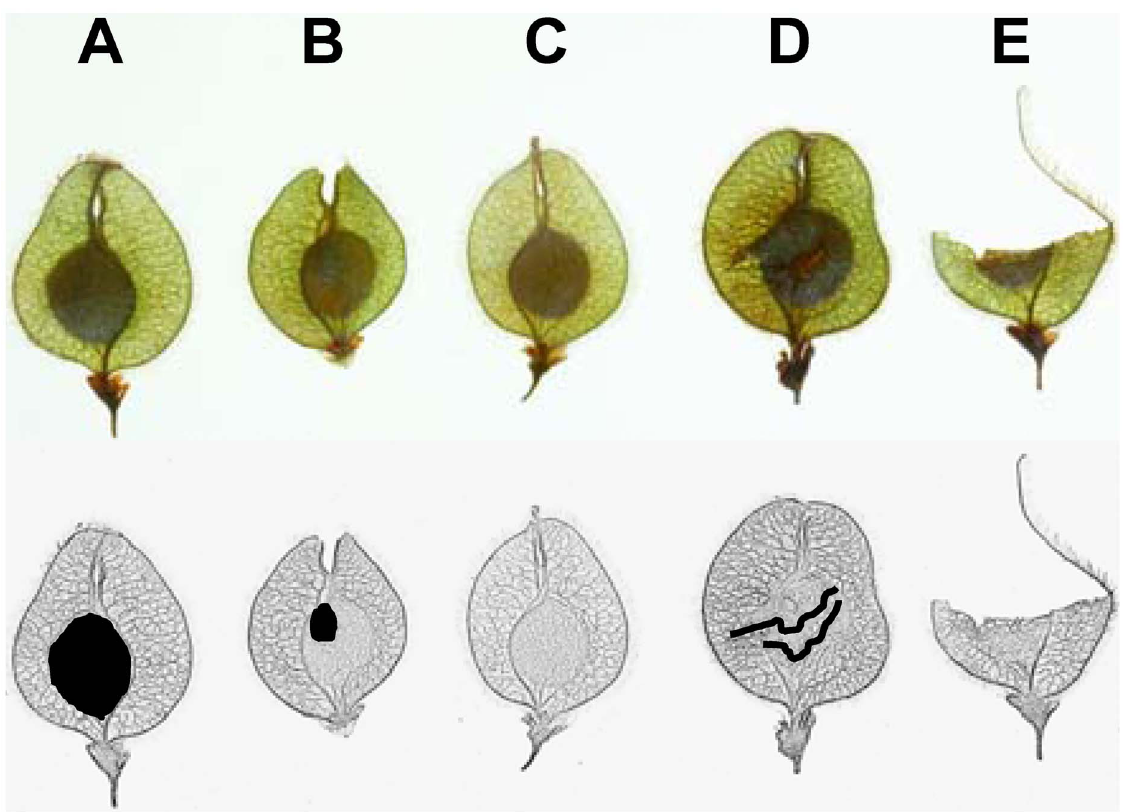
Figure 1. Ulmuslaevis samara characterization. Pictures of the different samara categories are shown on the top row and sketches on the bottom row: (A) full samara (FS); (B) undeveloped samara (US); (C) empty samara (ES); (D and E) predated samaras (PS). The black colour of the sketch stands out the seed for FS and US, and the tissues torn by animals in the PS.